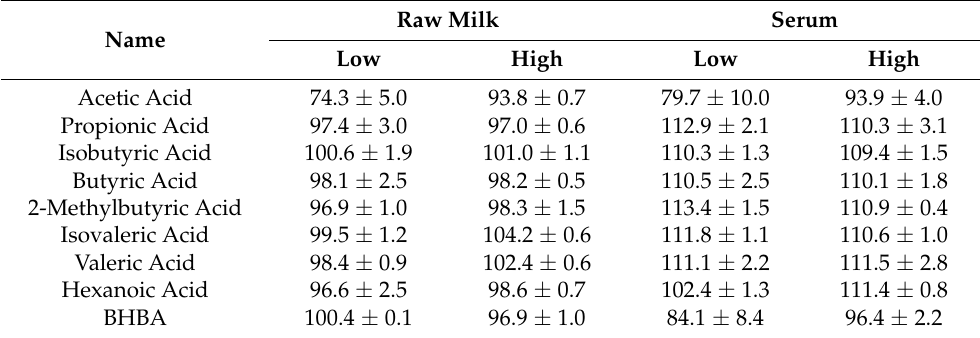
Table 3. Recovery (% ± SD, n = 3) of spiked SCFA from raw milk and serum matrices at two spike levels (Low: 0.33 µ g/mL each and High: 3.3 µ g/mL each).